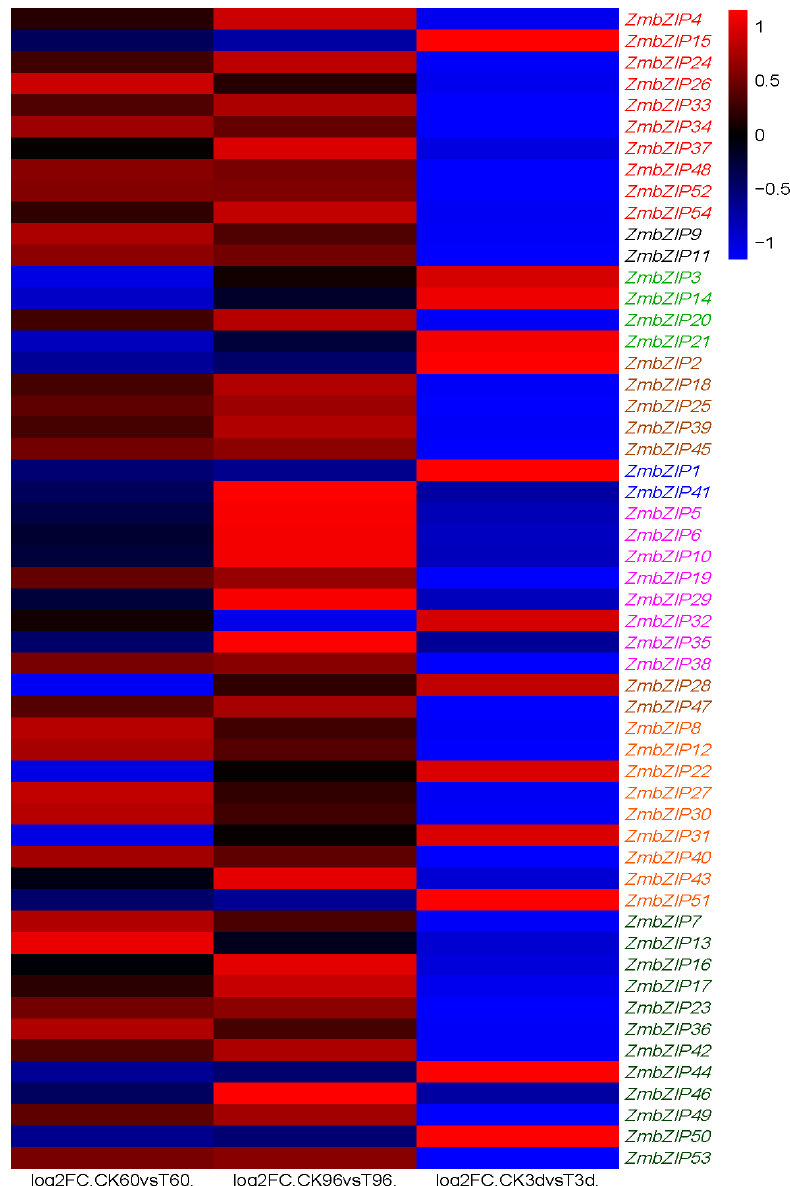
Figure 7. The expression pattern of 54 di ff erentially expressed ZmbZIPs screened by the drought and rewatering transcriptomes. The leaves of the three-leaf stage were stressed for 60 h and 96 h by polyethylene glycol (PEG), and rewatering for 3 d denoted as T60, T96, and T3d, and the control group was named CK60, CK96, and CK3d, respectively. The FC in log2FC.CK60 vs T60 is a fold change, which is the ratio of the expression between the CK60 sample and T60. It is log2FC after taking the base 2 logarithm; the same as log2FC.CK96 vs T96 and log2FC.CK3d vs T3d. Clustering was according to groups. Different colors represent different groups (from top to bottom are groups A, B, C, D, F, G, H, I, S). Genes highly or weakly expressed in the tissues are shown in red and blue, respectively. These results indicated that groups have particular functions, but the mechanism of the action can differ within each group. It is likely that individual bZIP genes or groups of bZIP genes co-operate